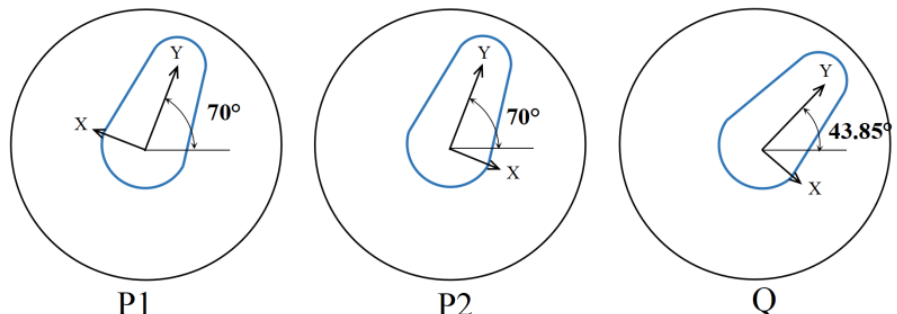
Figure 5. The installed angle of the shaft-pin-type sensor.